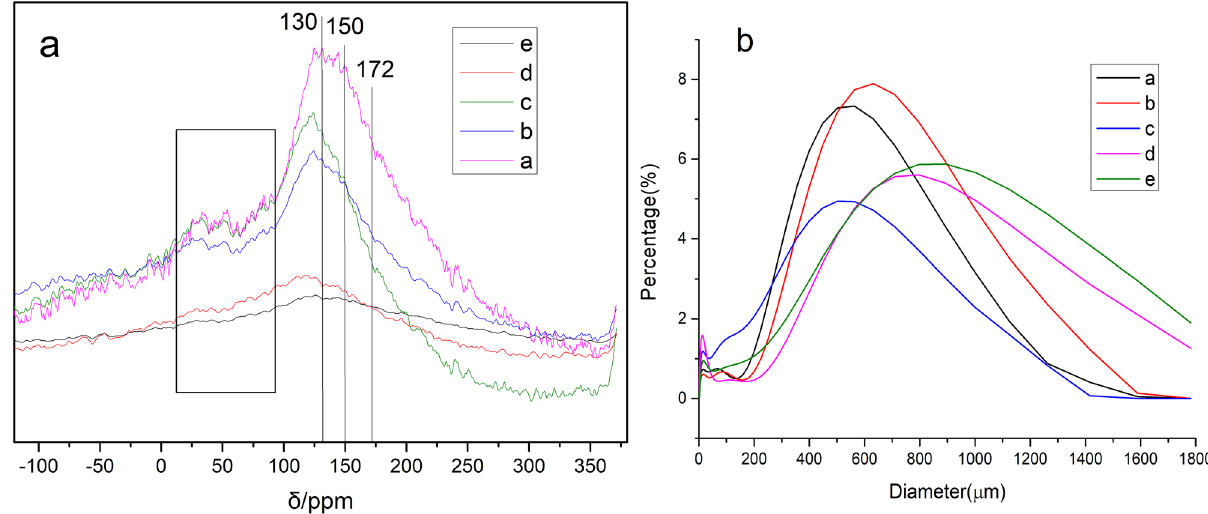
Figure 3: ( a ) The C 13 NMR spectrum of the carbon solid acid catalysts prepared with di ff erent mass ratios of raw materials. ( b ) Size distribution results of the carbon solid acid catalysts prepared with di ff erent mass ratios of raw materials: ( a ) G/F - 1/4, ( b ) G/F - 1/3, ( c ) G/F - 1/2, ( d ) G/F - 1/1, ( e ) G/F -